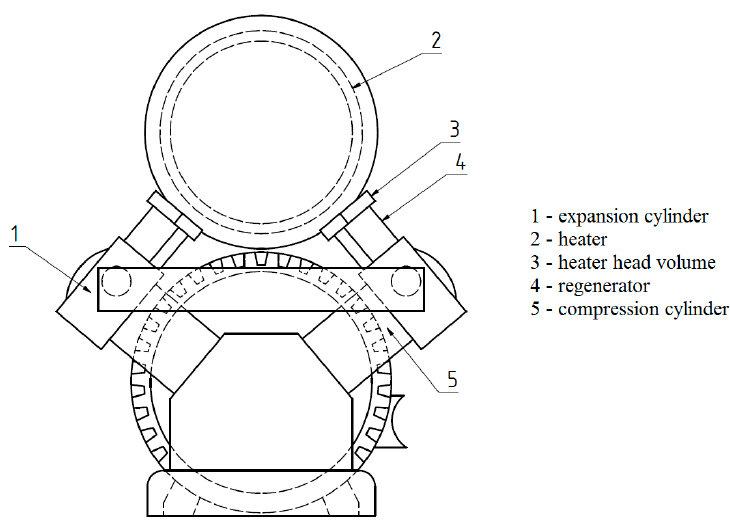
Figure 1. Cleanergy α —type Stirling engine, adaptation from [11].